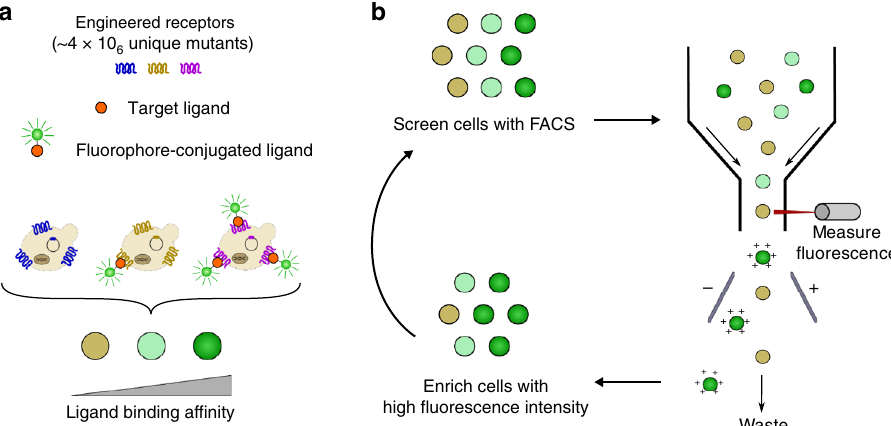
Fig. 2 Diagram of FACS-based GPCR directed evolution and screen. a A library of the human adenosine A 2 a receptor (A 2 aR) was generated using degenerate NNS codons to perform saturation mutagenesis at fi ve sites within the ligand-binding pocket. Yeast are transformed with the A 2 aR library and incubated with fl uorescent ligand to couple ligand-binding af fi nity to cellular fl uorescence intensity. b The yeast library is screened using fl uorescence- activated cell sorting (FACS) to enrich cells producing A 2 aR variants with high fl uorescence intensities. This process is repeated to further enrich receptors with improved ligand-binding af fi nities while depleting the population of variants with low af fi